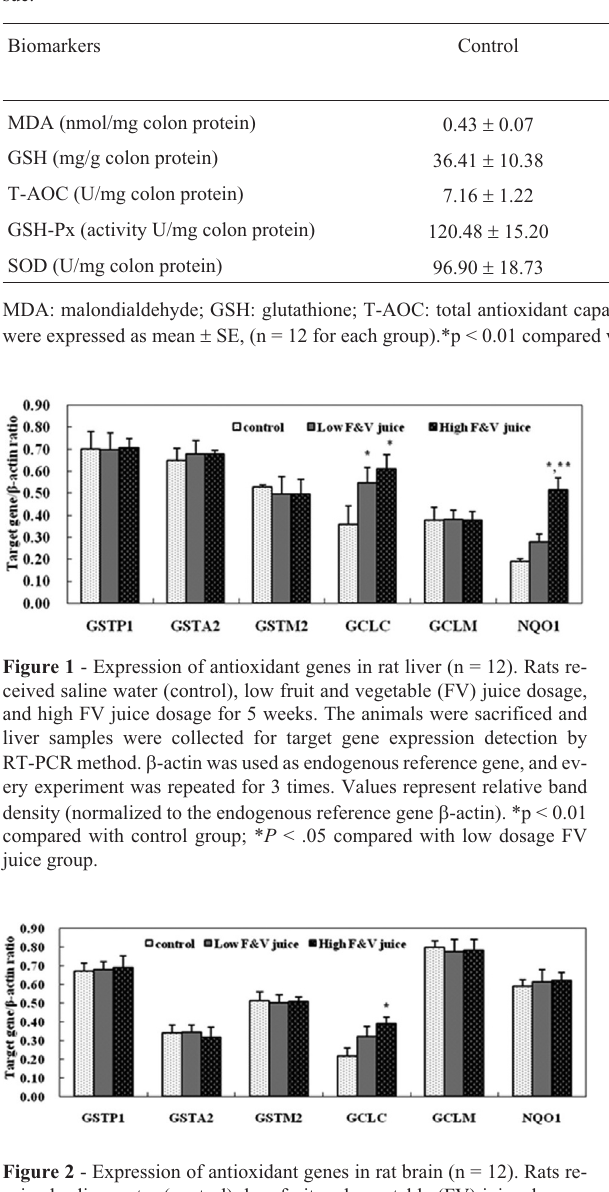
Table4 -Effectsoffruitandvegetable(FV)juicedietaryinterventiononMDA,GSH,T-AOClevels,GSH-PxandSODenzymeactivitiesinratcolontis- sue.